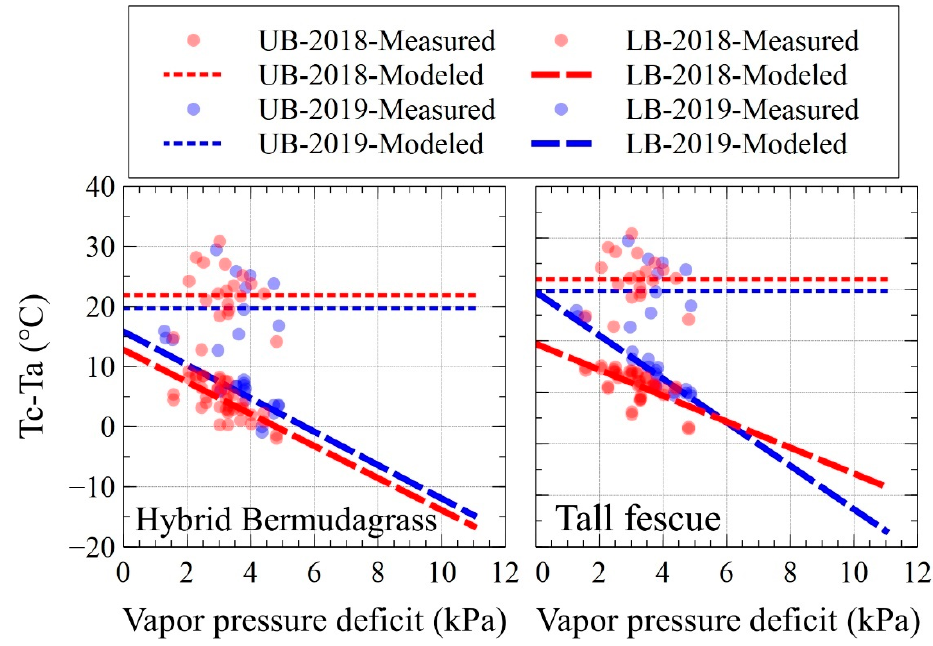
Figure 6. Graphical illustration of the lower (LB) and upper (UB) baselines of canopy temperature (Tc) minus air temperature (Ta) difference versus vapor pressure deficit for hybrid bermudagrass and tall fescue species in central California. Table 4. Lower CWSI baselines for tall fescue and hybrid bermudagrass. Tall Fescue Hybrid